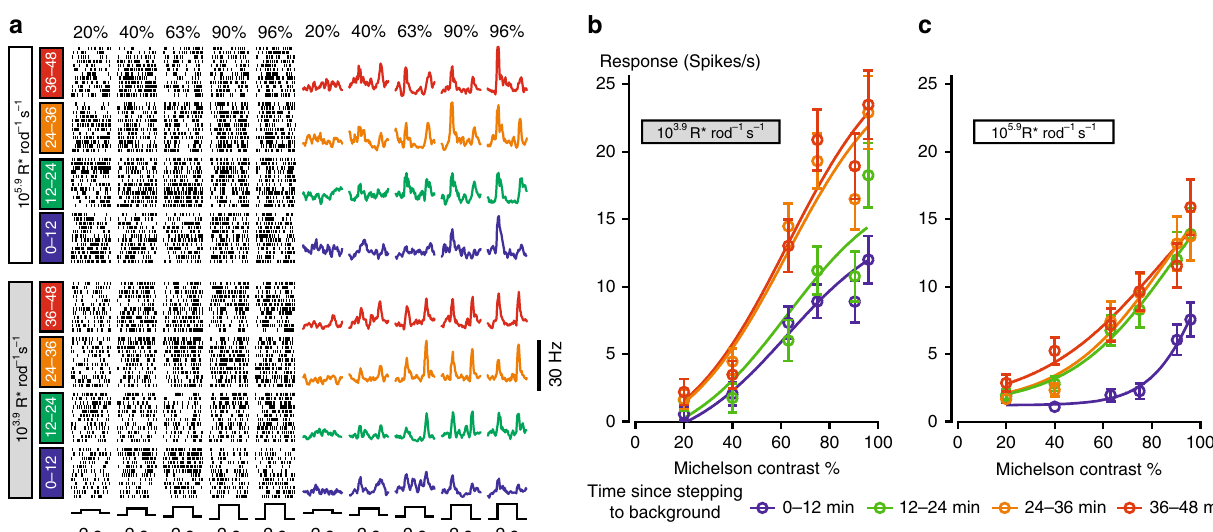
Fig. 5 Incremental saturation in rod-driven responses in the Cnga3 − / − LGN. a Example peri-event rasters (left) and peri-event histograms (right) for a single LGN multiunit in response to spectrally neutral modulations in background light intensity across a range of contrasts (different columns) and at various time points (different colors, range in min given on the left) after stepping to that background. b , c Mean ± s.e.m. contrast – response relationship across 86 LGN multiunits (from four mice) at varying time points after stepping to the 10 3.9 R* rod − 1 s − 1 background ( b , from darkness) or 10 5.9 R* rod − 1 s − 1 ( c , from 10 3.9 R* rod − 1 s − 1 ). Continuous curves represent the best- fi tting 4-parameters sigmoid